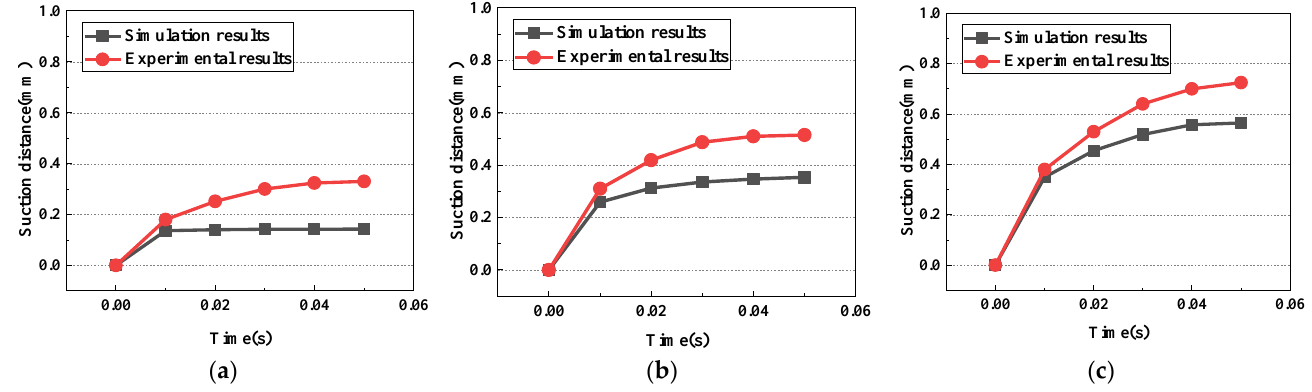
Figure 6. Comparison of simulated and experimental suction distances in microchannels of different widths. ( a ) 12 μm ; ( b ) 20 μm ; and ( c ) 30 μm. Table 2. Roughness of three silicon-based